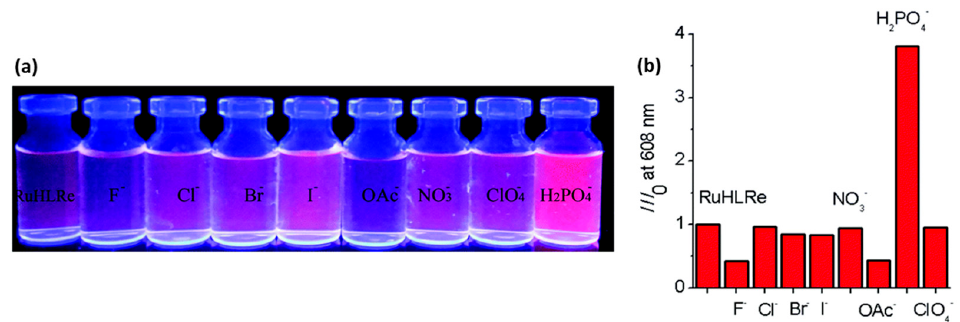
Figure 7. ( a ) Photographs of acetonitrile solutions of 44 (10 μ M) taken under a UV − lamp in the ab- sence and presence of 10 equiv. of anions. ( b ) The PL emission intensity ratios of 44 were plotted in the presence and absence of the anions ( λ ex = 460 nm). [Reproduced from reference [81]; Copy- right © 2023, Royal Society of Chemistry]